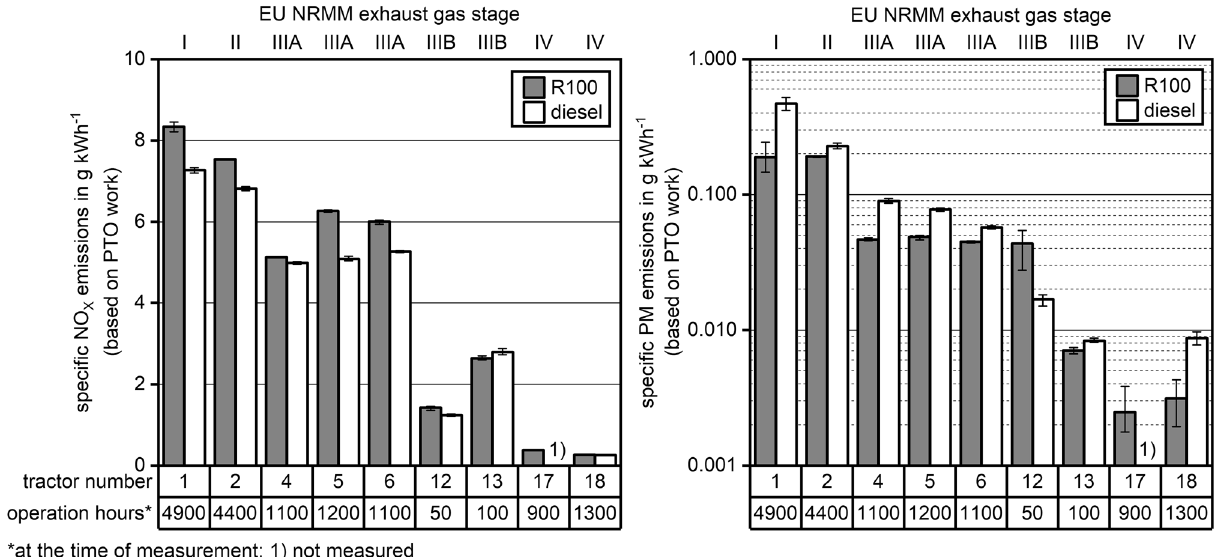
Fig. 8 Specific NO and PM emissions (arithmetic mean and maximum deviation, n = 3) of the tractors applying the non-road-stationary- X cycle